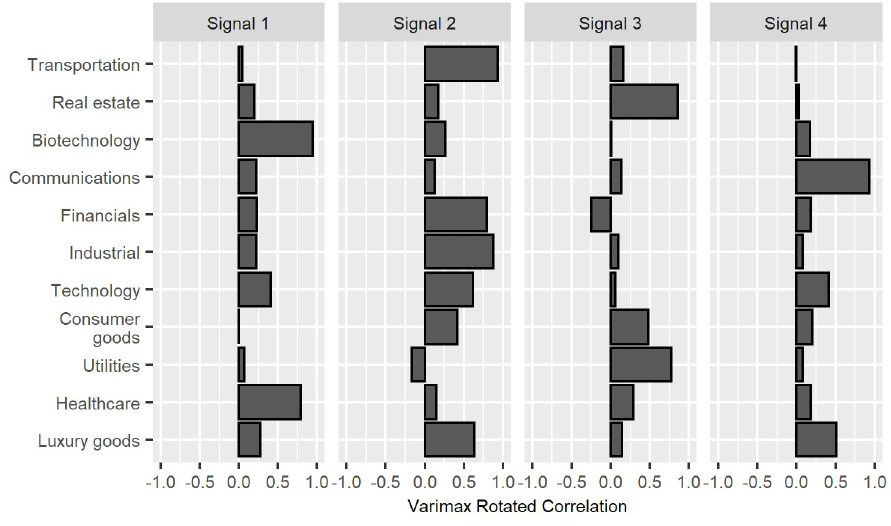
Fig 2. Varimax rotated correlation of variables with four leading